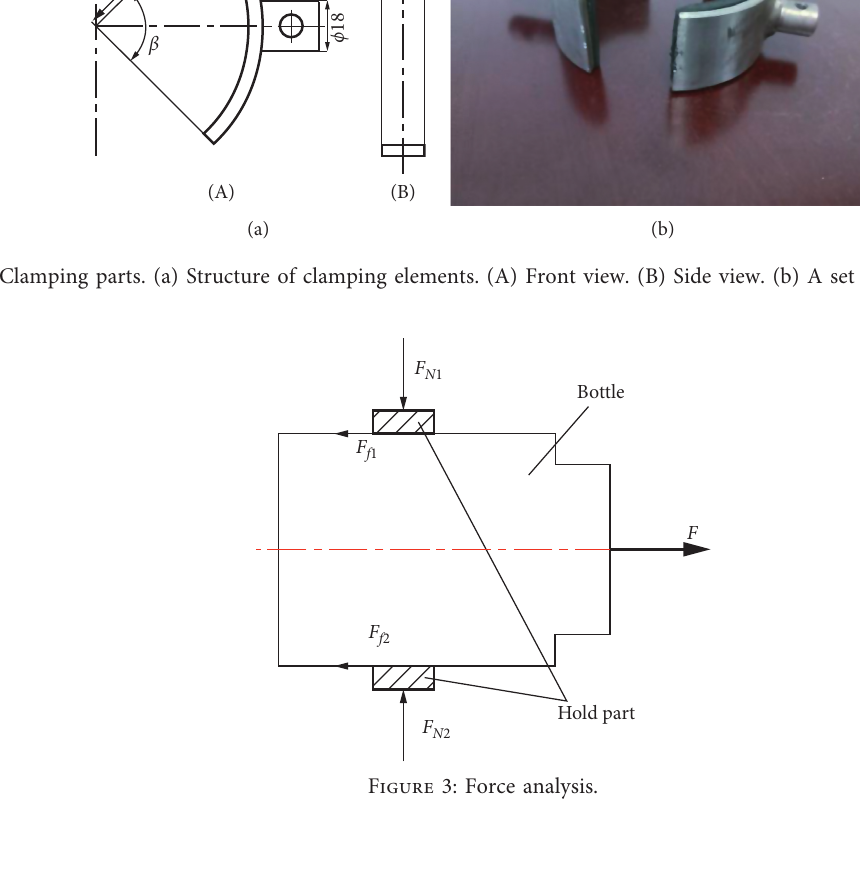
Table 1: Factors and levels of single-factor test.